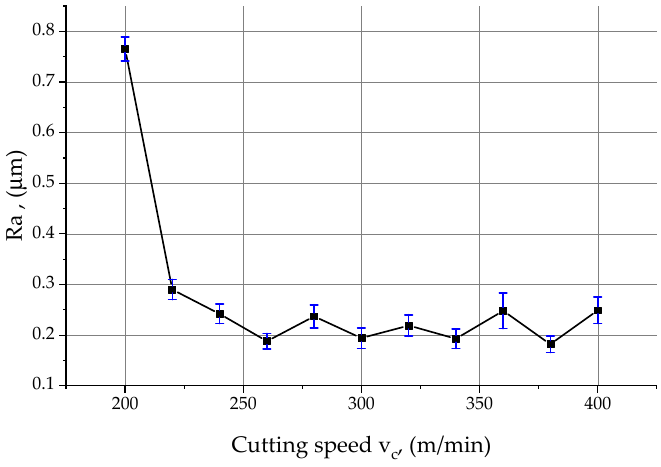
Figure 12. Effect of cutting speed on the Ra parameter of surface roughness during face milling of samples made of 2017A alloy.